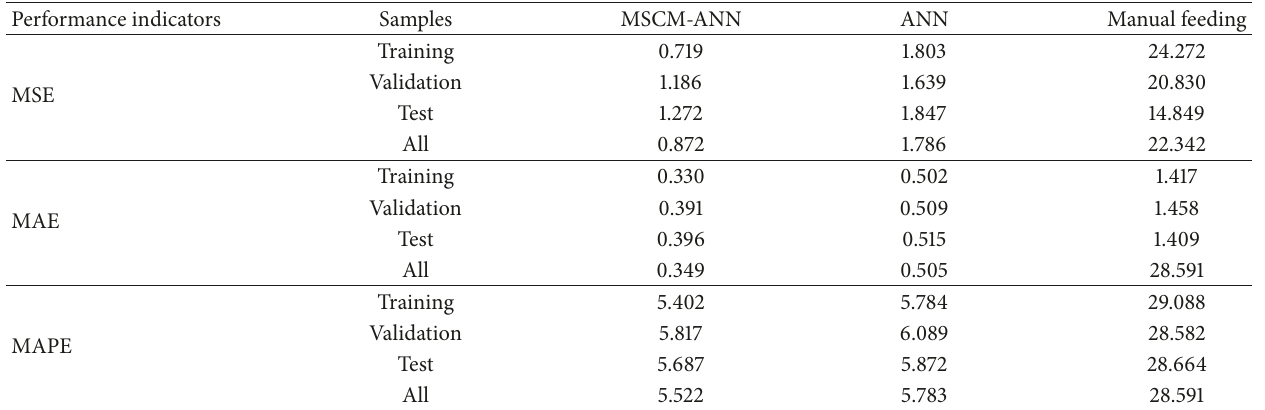
Table 6: Performance indicators achieved by different